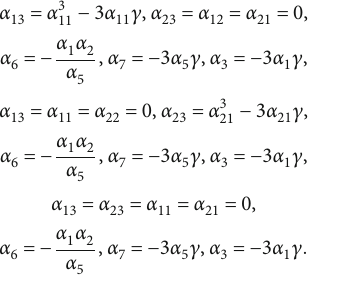
= − 2 . (a) y = − 3 , (b) y = 0 , and (c) y = 2 5